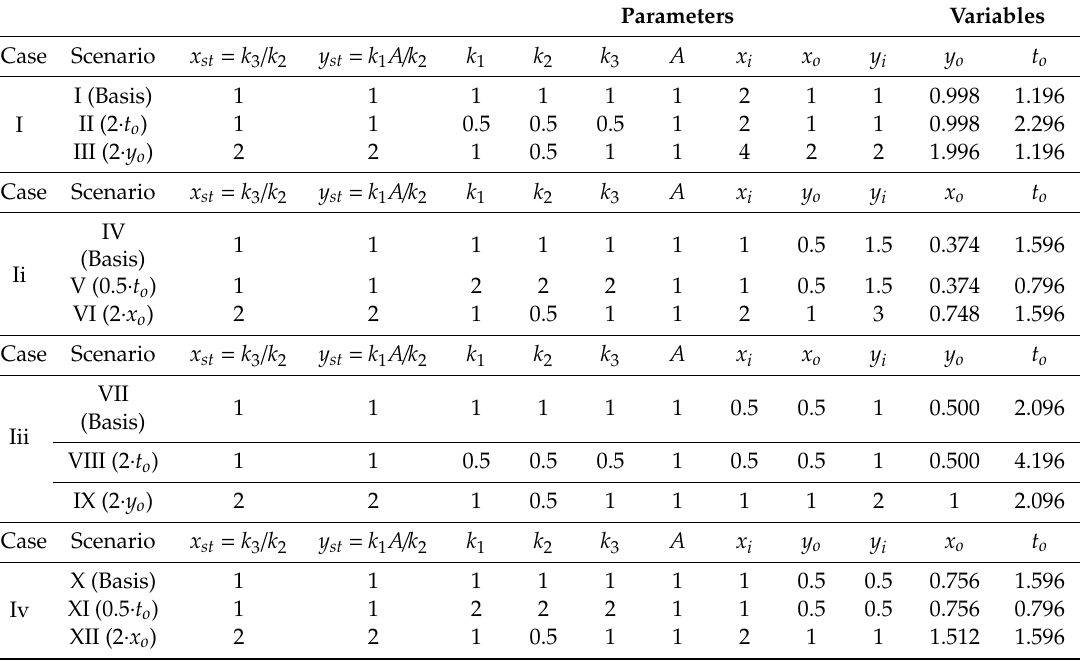
Table 1. Checked cases in Lotka–Volterra oscillator problem. Parameters